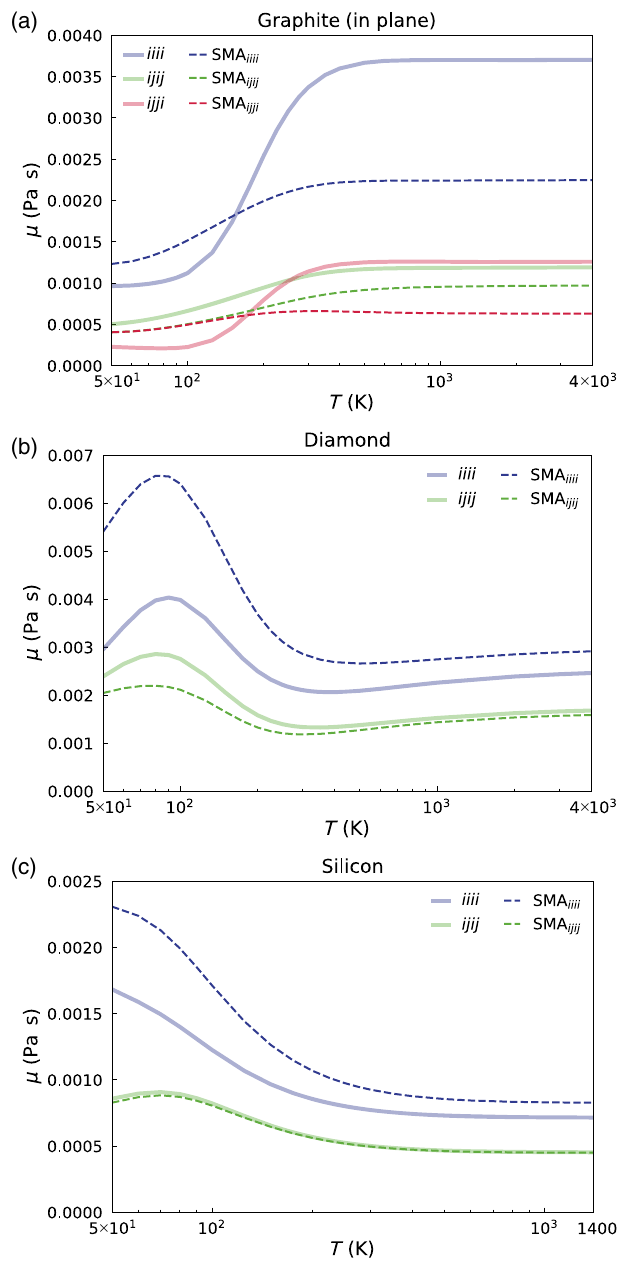
FIG. 7. Comparison between the exact bulk thermal viscosity (solid lines) and the SMA bulk thermal viscosity (dashed line) for in-plane graphite (a), diamond (b), and silicon